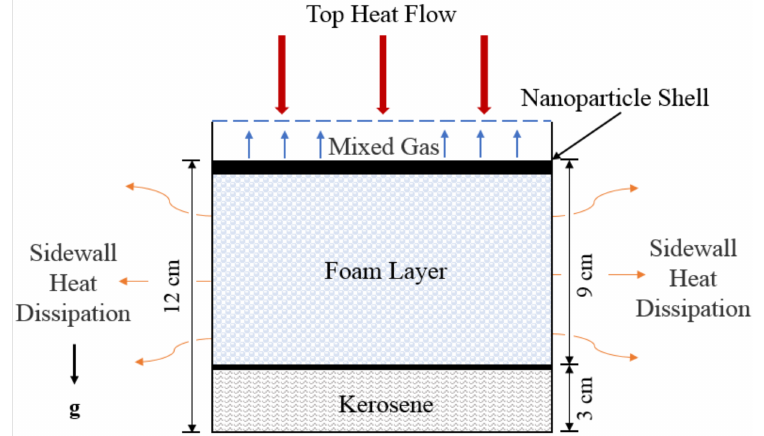
Figure 1. Simulation domain of the three-phase gel foam